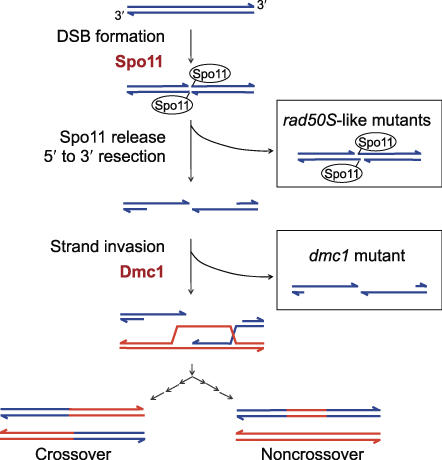
Meiotic Recombination Pathway as Elucidated in S. cerevisiae
Recombination is initiated by Spo11-generated DSBs. (The DNA duplex from only one of two sister chromatids is shown.) Spo11 is then released and the 5′ ends of DSBs are degraded to yield 3′ single-stranded DNA tails. The single-stranded DNA invades one of the two sister chromatids of the homologous chromosome (only one of the homolog's chromatids is shown). Strand invasion is catalyzed by Dmc1 (and/or Rad51, not shown). Completion of repair yields either reciprocal exchange of chromosome arms that flank the break (a crossover) or no exchange of flanking arms (a noncrossover). In rad50S-like mutants, Spo11 remains covalently attached to DNA, and the DSBs are not repaired. In dmc1 mutants, DSBs persist with long, single-stranded DNA tails.